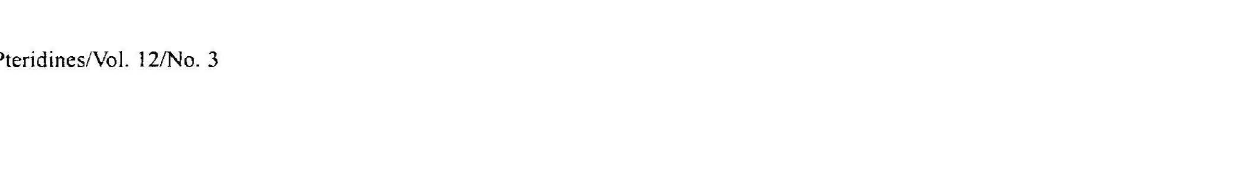
Synechococcus sp. PCC 7942 has a-glycosidic